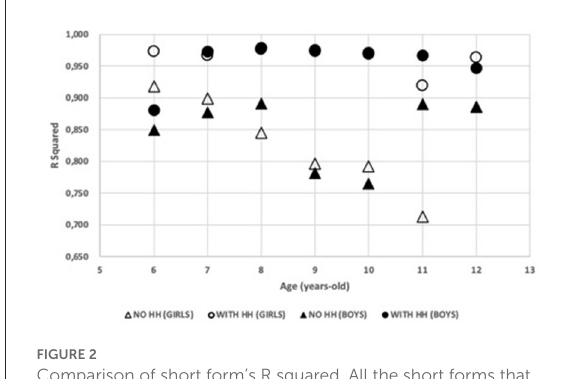
without HH (triangle), per sex (boys, full; girls, empty). NO HH, it is considering three items KTK with the highest R